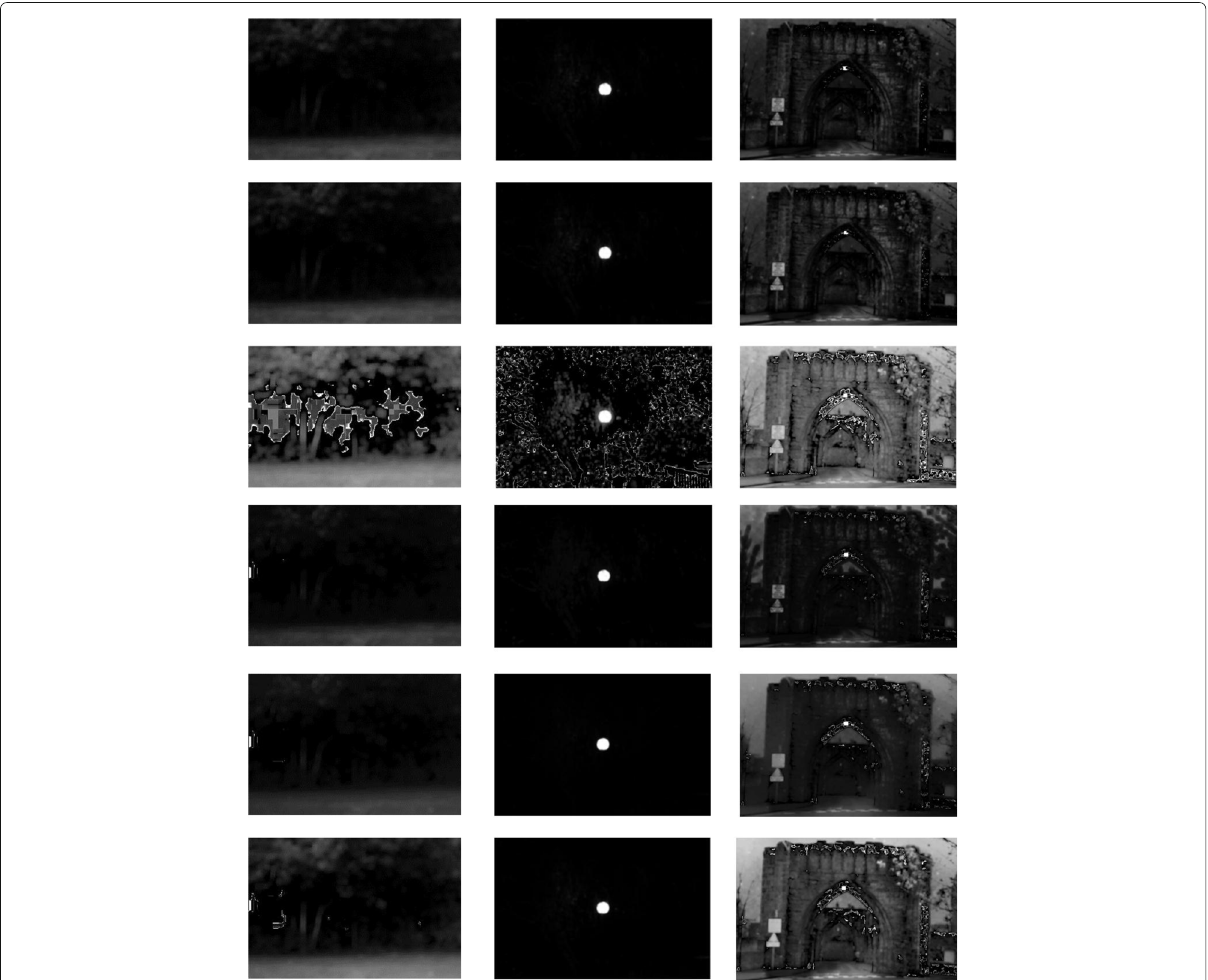
Fig. 15 The quality maps of different methods on the three images in Figure 12. From top to bottom are map for MSR [11], map for MSRCR [13], map for negative dark channel [20], map for bright channel prior [21], map for LIME [23], and that for proposed method color distortion in the results with MSR [11] (the second